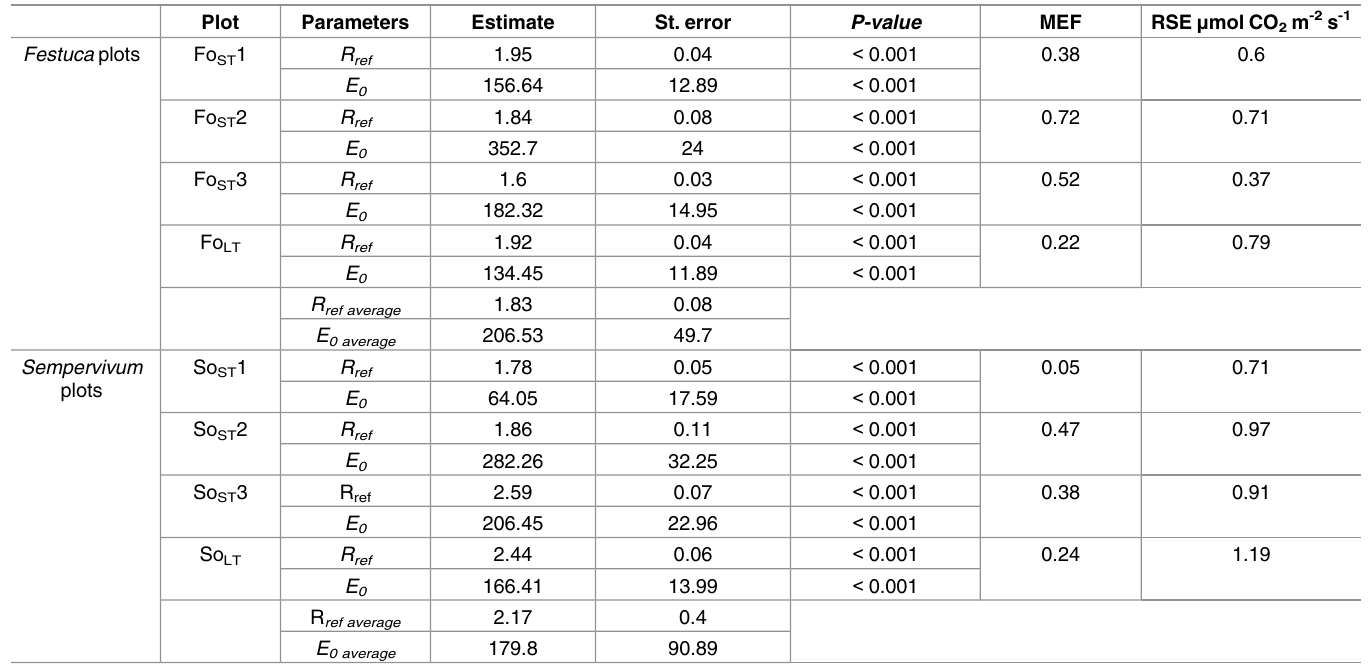
Table 3. Respiration flux at the constant reference temperature T 0 = 10˚C ( R ref ) and the temperature sensitivity ( E 0 )